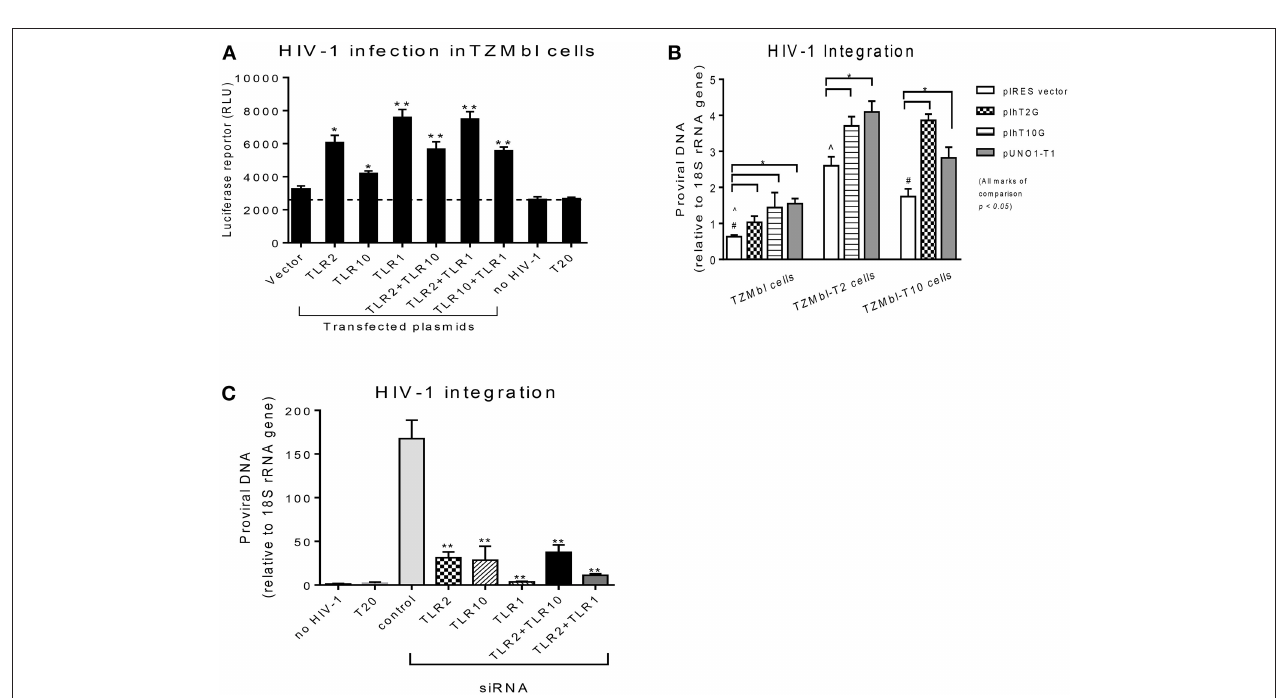
FIGURE 3 | Overexpression or siRNA mediated knockdown of TLR10 significantly alters HIV-1 infection and integration (A) HIV-1 infection was significantly enhanced in HIV-1 reporter TZMbl cells transiently overexpressing TLR10 alone and co-transfected with TLR2 or TLR1 expression plasmids by measuring luciferase activity in relative light units (RLU). (B) HIV-1 integration was significantly increased in stable TZMbl reporter cells overexpressing TLR10, TLR2, and TLR1. TZMbl, TLR2- stable, and TLR10-stable cells were used for co-transfection with plasmids: empty vector, TLR2, TLR10, and TLR1 vector, TLR10 and TLR1 vector, and TLR2 and TLR1 vector. Proviral DNA (DNA pol) was detected by PCR and normalized to the 18S rRNA gene. (C) Proviral DNA was obviously decreased in macrophages with TLR10 knocked down prior to HIV-1 infection. T20: Enfuvirtide, an HIV-1 fusion inhibitor used as a negative control. Data set is representative of three different experiments completed in triplicate (Statistic marks in the plots: * p < 0.05, ** p < 0.01 for Mann Whitney t -tests, each group compared to the vector group in A and B, or to the control group in C; pair comparison ∧ , # in B, respectively).